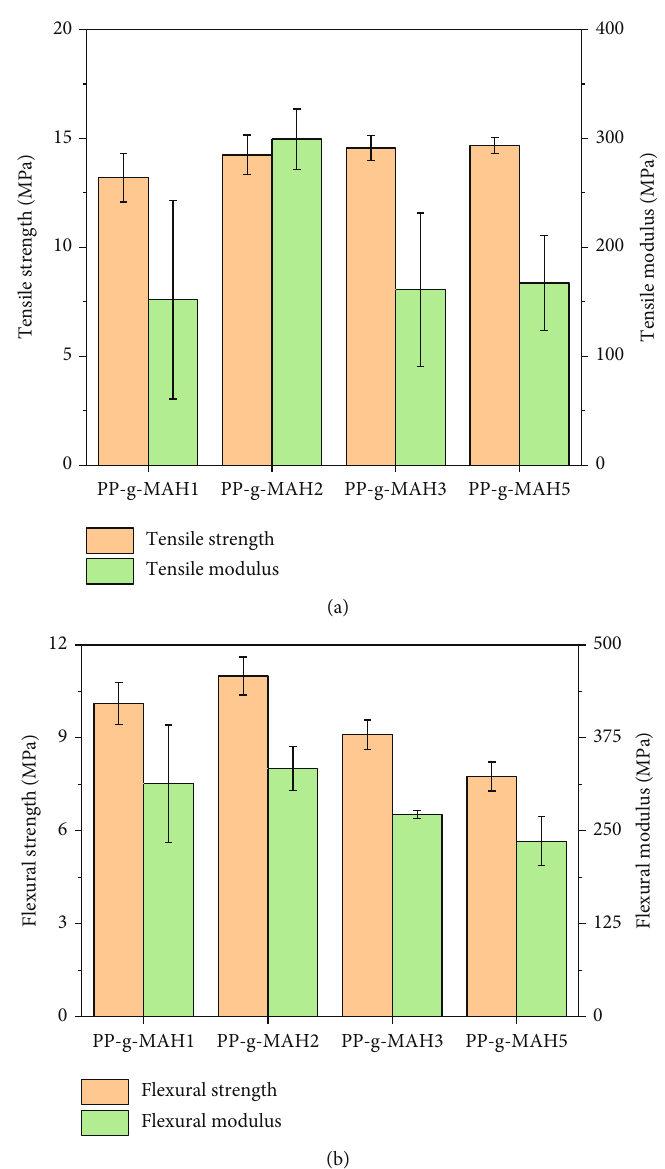
Figure 5: (a) The tensile strength and tensile modulus and (b) the fl exural strength and fl exural modulus of SUPAs with di ff erent PP-g- MAH